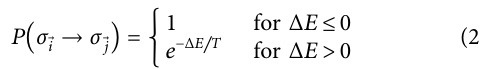
. Each symbol is derived from an individual cs